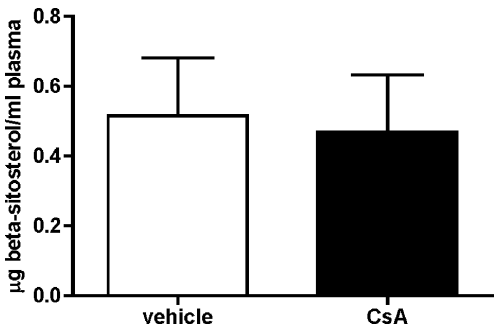
Figure 7. CsA treatment effect on plasma levels of beta- sitosterol. C57BL/6 mice were treated with CsA as described in Figure 1. The plasma content of beta-sitosterol was measured by gas chromatography, as described in the Method section. Data are presented as means 6 SD (n=6).